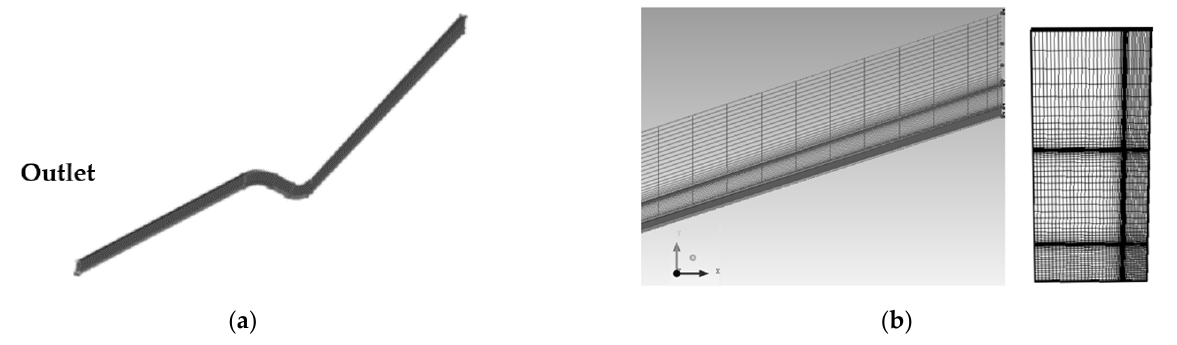
Figure 10. Numerical modelling: ( a ) global view of cooling channel model extracted from cooling system geometry; ( b ) mesh distribution with a detail on inlet zone (axial direction) and on a transversal section (divergent zone). Table 2. Grid-independence test results.